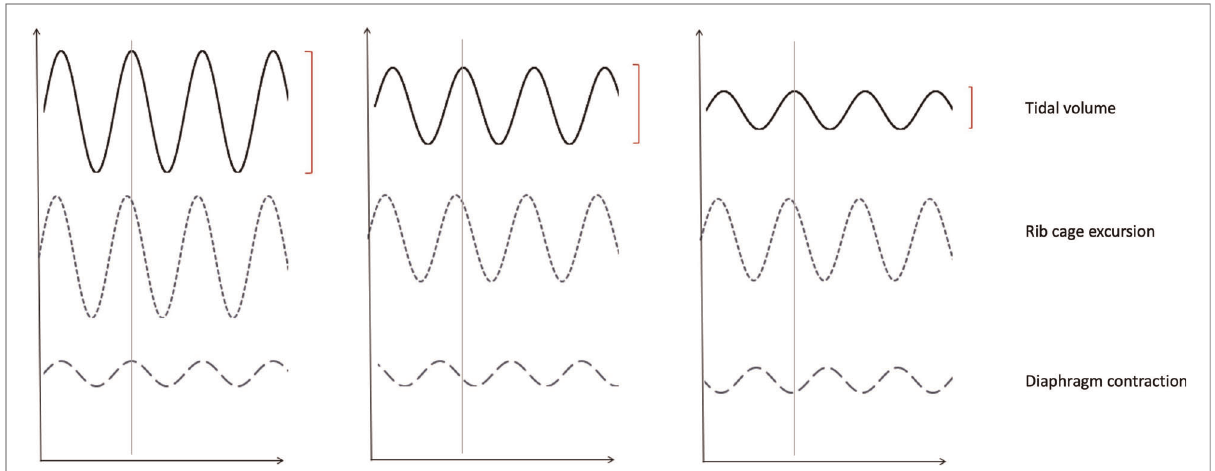
FIGURE 5 Impression of thoracic abdominal movements with respiratory cycle. ( A ) Demonstrates normal thoraco-abdominal movements with respiration, with ( B ) Illustrating partial dyssynchrony of diaphragm contraction and ( C ) complete asynchrony causing paradoxical diaphragmatic movement. Note the decreasing tidal volumes with progressive